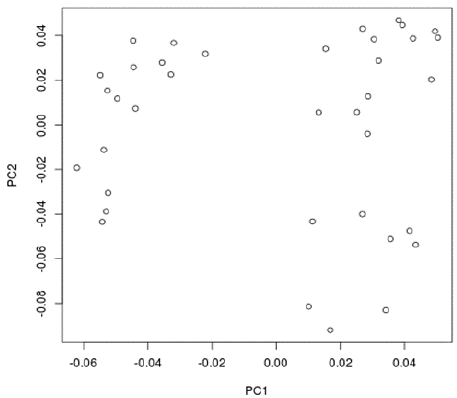
Figure 1. Multi Dimentional Scaling Plot (MDS) graph constructed using post-quality control autosomal markers with r 2 < 0.2.